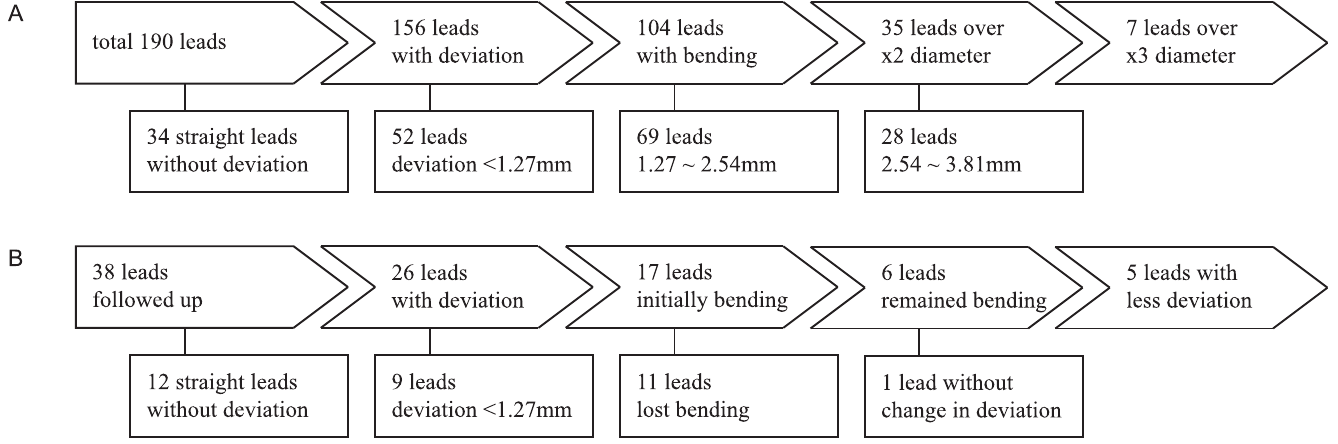
Fig 4. Flow chart of intracranial leads. A. Deviation of intracranial leads immediately after surgery. B. Temporal changes.